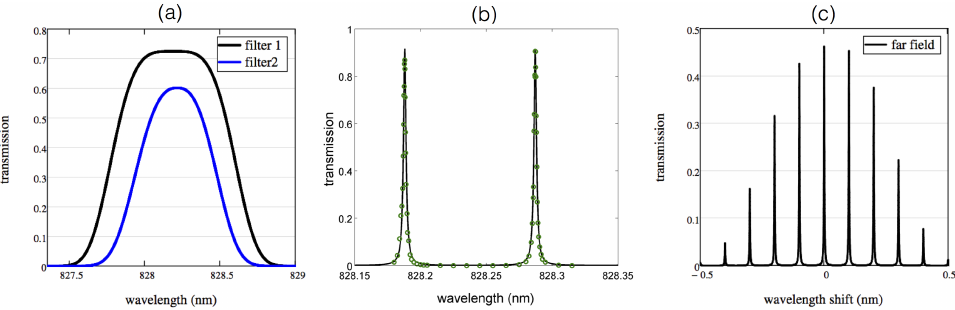
Figure 2. The multistage optical filtering enabling measurement of water vapor during daytime bright-cloud conditions. (a) The interference filter transmission as a function of wavelength: the solid black (blue) line is a fit to the measured filter transmission for the FWHM bandpass of 750pm (500pm). A double cavity design was used for both filters to provide a more flat passband. The wider filter is common to both the near- and far-range channels while the narrower filter is used only in the far-range channel. (b) The etalon transmission as a function of wavelength; the green circles represent measured values while the solid black line represents a fit. (c) The combined passband for the far-range channel including both interference filters and the